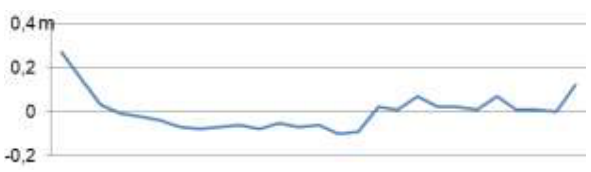
Figure 19. Systematic Z-discrepancies of Kompsat-3 DSM as function of X; profile length = 34km